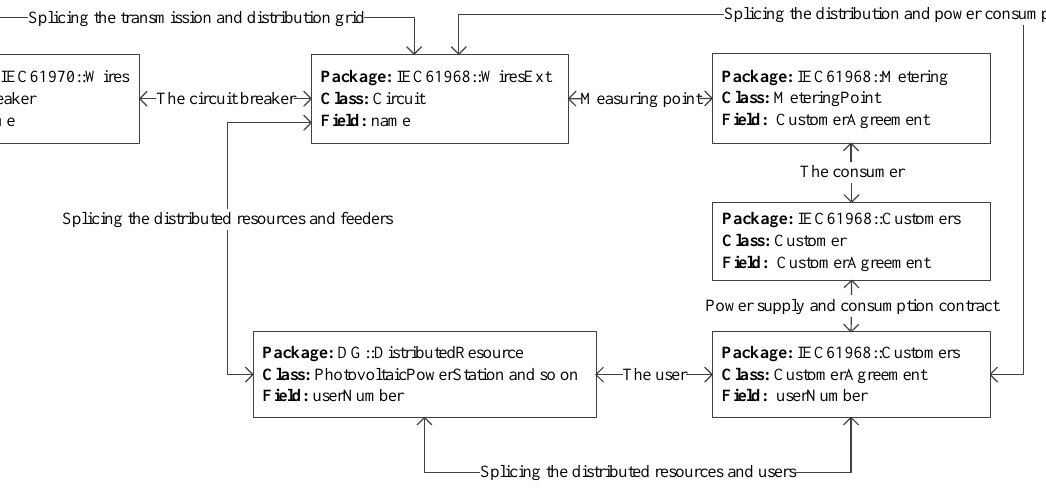
Figure 9. The class diagram for the flexible load in the distributed resource package.